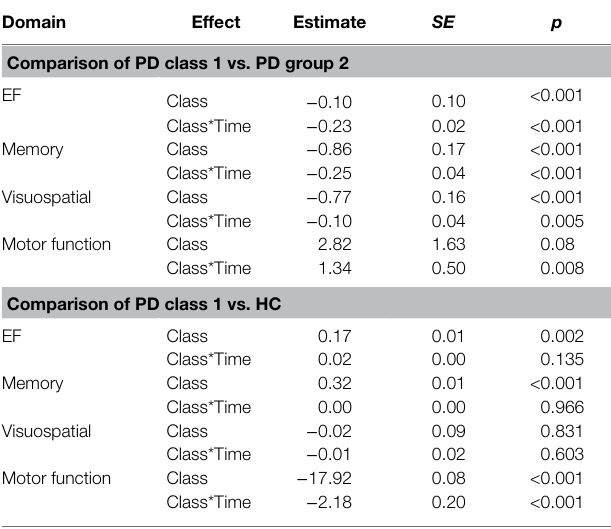
TABLE 1 | Post-hoc linear mixed effects